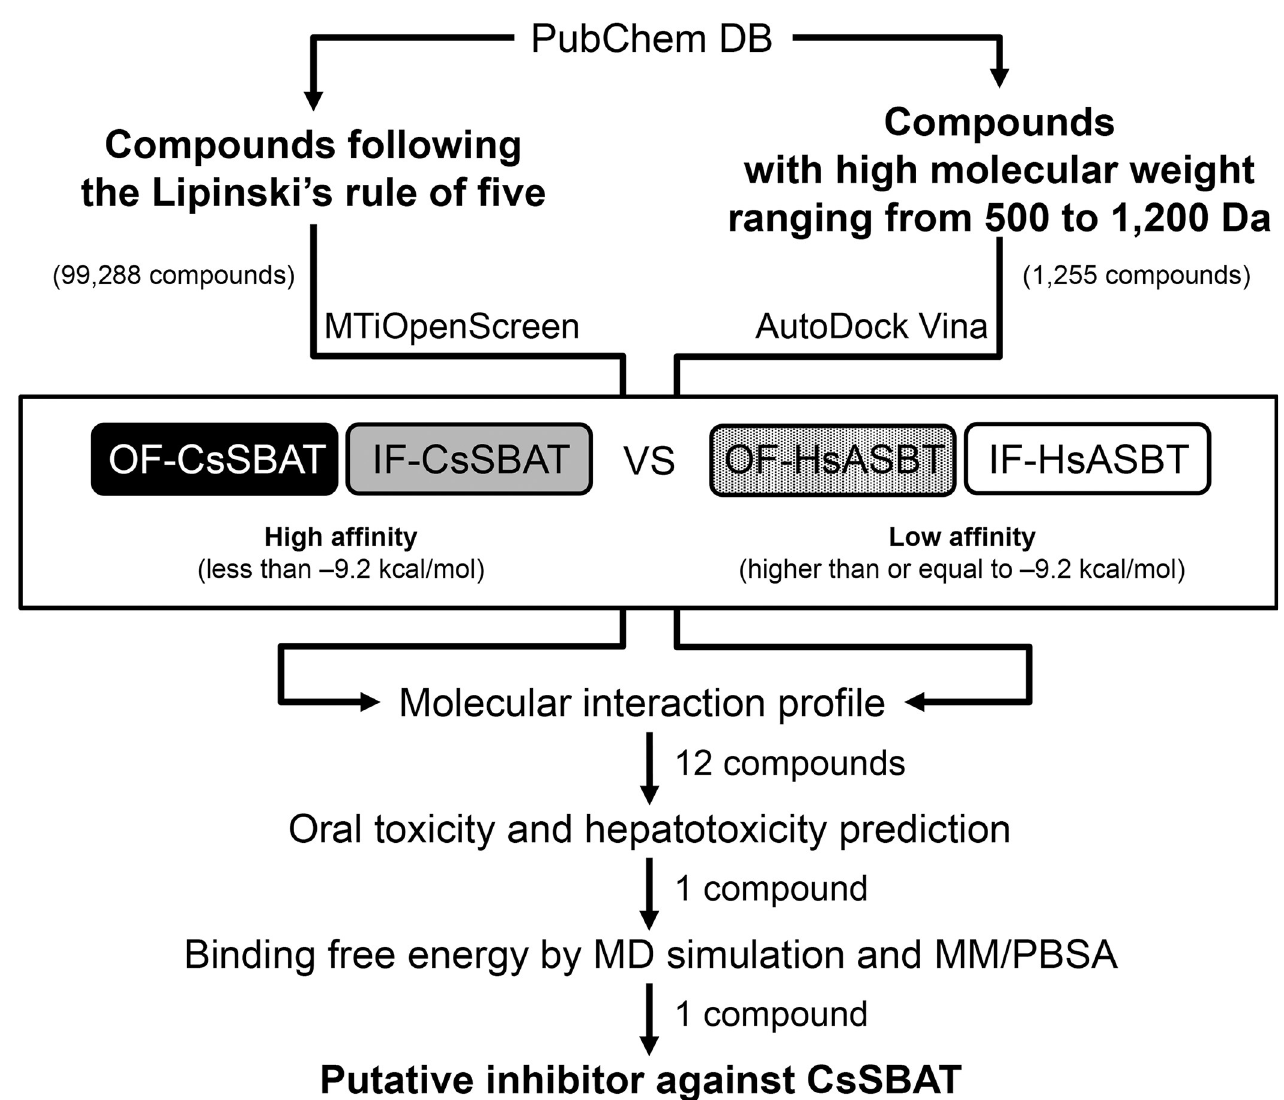
Fig 1. Strategy for structure-based virtual